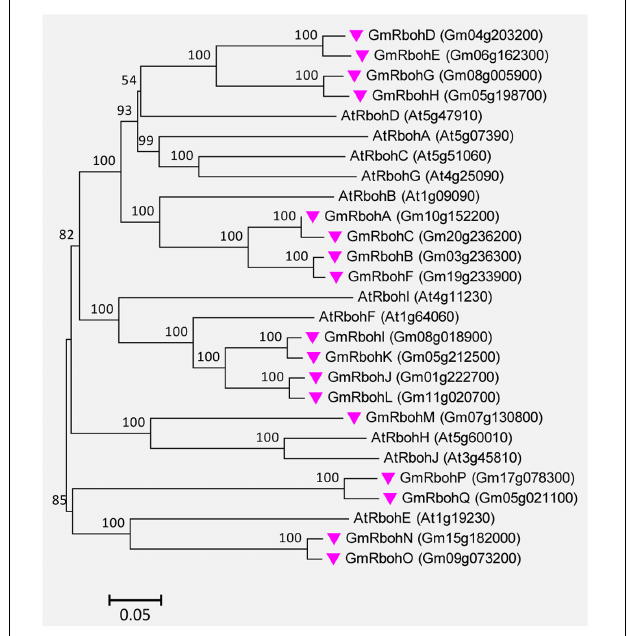
FIGURE 8 | Unrooted phylogenetic tree of the Rboh proteins from soybean ( G. max ) and A. thaliana . The alignment for the phylogenetic tree was performed with ClustalW using full-length amino acid sequences. The phylogenetic tree was created with the MEGA6 software and the neighbor-joining method with 1,000 bootstrap replications. Seventeen GmRbohs are marked with pink inverted triangles, while 10 AtRboh proteins are not marked. Locus name of each gene is shown in brackets. The bar indicates the relative divergence of the sequences examined and bootstrap values are displayed next to the